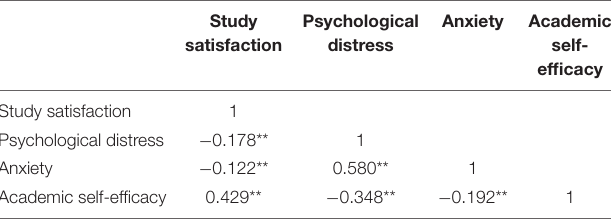
TABLE 1 | Descriptive analyses of study satisfaction, psychological distress, anxiety, and academic self-efficacy. Variables M SD Sc K